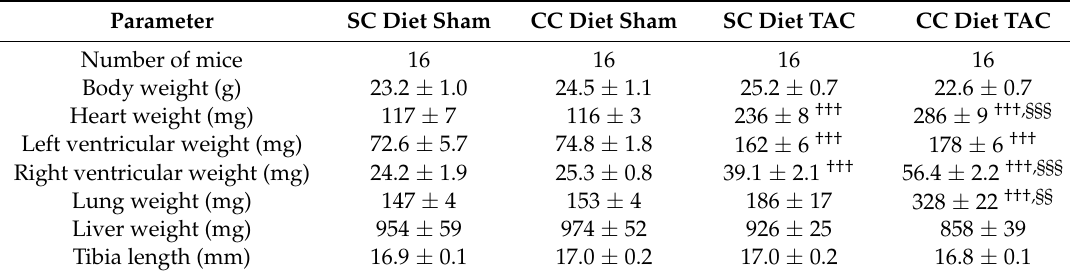
Table 2. Body weight and organ weights in female C57BL/6 mice eight weeks after sham or TAC procedure in C57BL/6 mice fed the SC diet or the CC